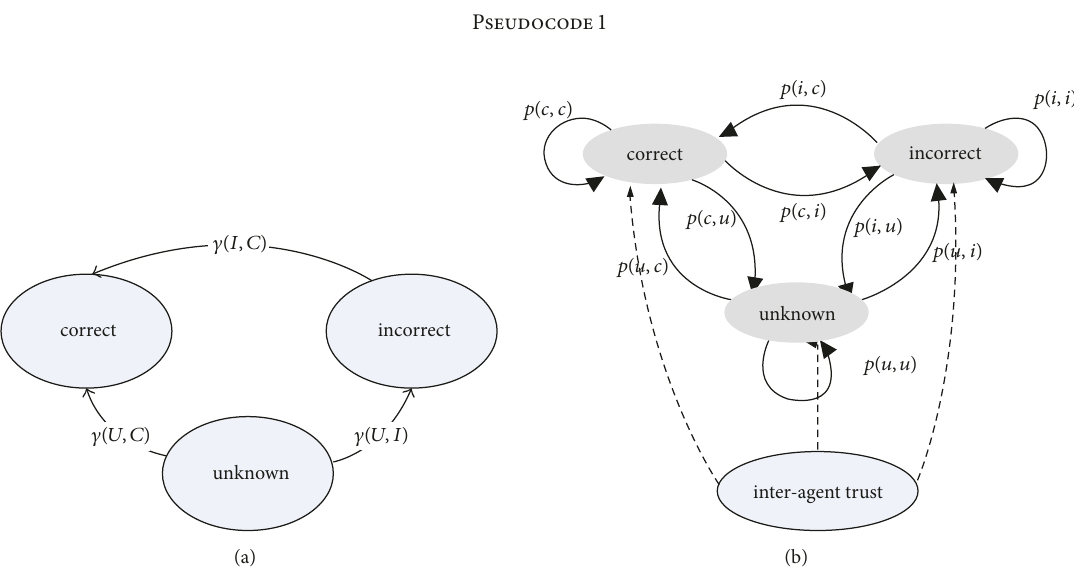
Figure 1: Interstate transition models for ABM and PBM. (a) State transition model for PBM; (b) state transition model for ABM partially adopted from